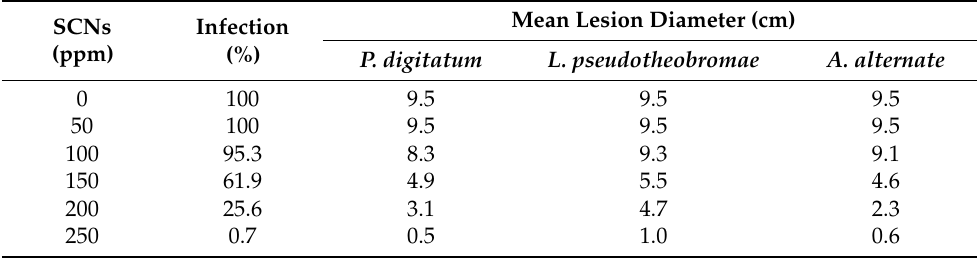
Table 2. The antifungal activity of SCNs at different concentrations against three fungi on Citrus reticulata